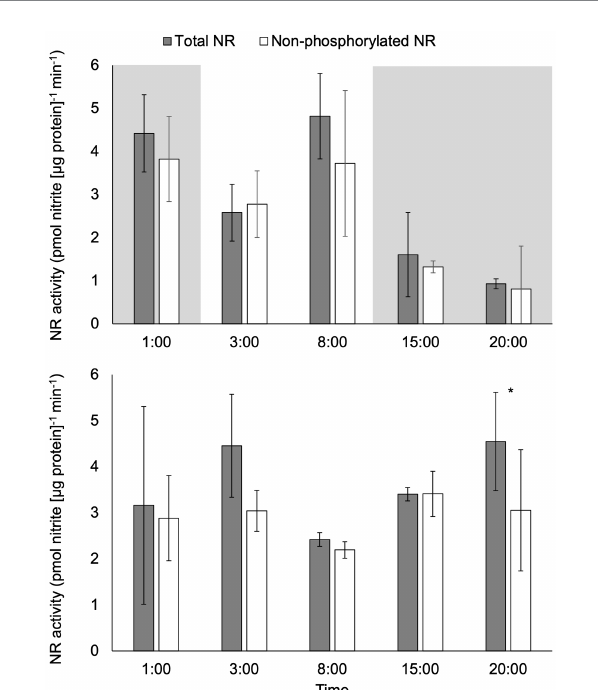
FIGURE 3 Activity (pmol nitrite [ μ g protein] − 1 min − 1 ) of total NR and non- phosphorylated NR in C. subsalsa cultured in a 12:12 h light: dark cycle (upper panel) or constant light (lower panel) in the long-term light experiment. The portion with shade indicates the time that was in dark for algae cultured with the light: dark cycle. Samples were taken at 1 h before lights on (1:00), 1 h after lights on (3:00), 6 h after lights on (8:00), 1 h after dark (15:00), and 6 h after dark (20:00). Asterisk (*) reveals the significant difference in NR activity between total and non-phosphorylated NR, indicating the regulation by reversible phosphorylation and the subsequent binding of putative 14-3-3 proteins, at the indicated time point ( p < 0.05). Error bars are standard deviation of three biological